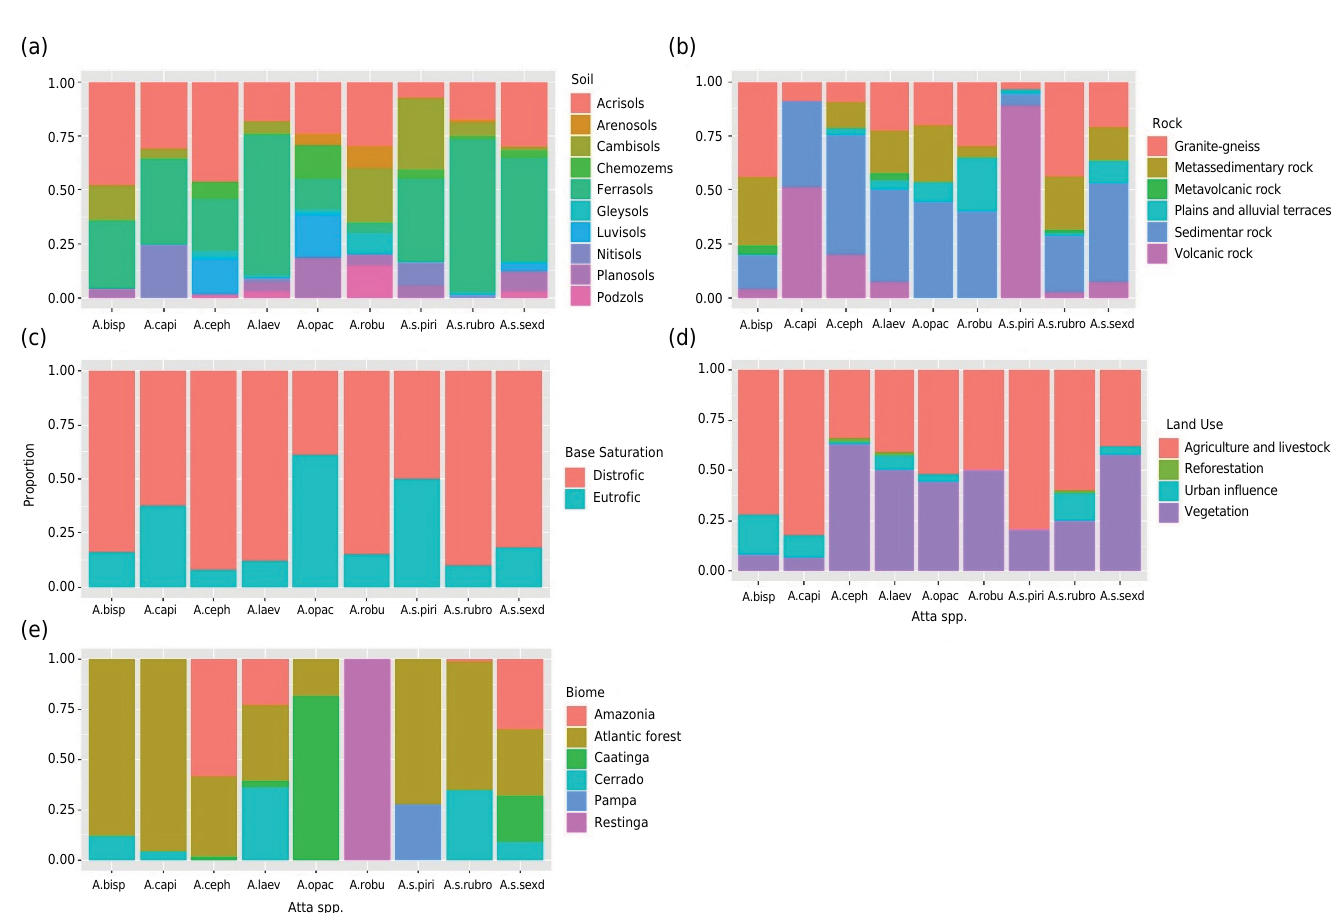
Figure 2. The proportion of Atta points occurrence and respective variables of the soils (a), rocks (b), land-use (d), base saturation (c) and biome